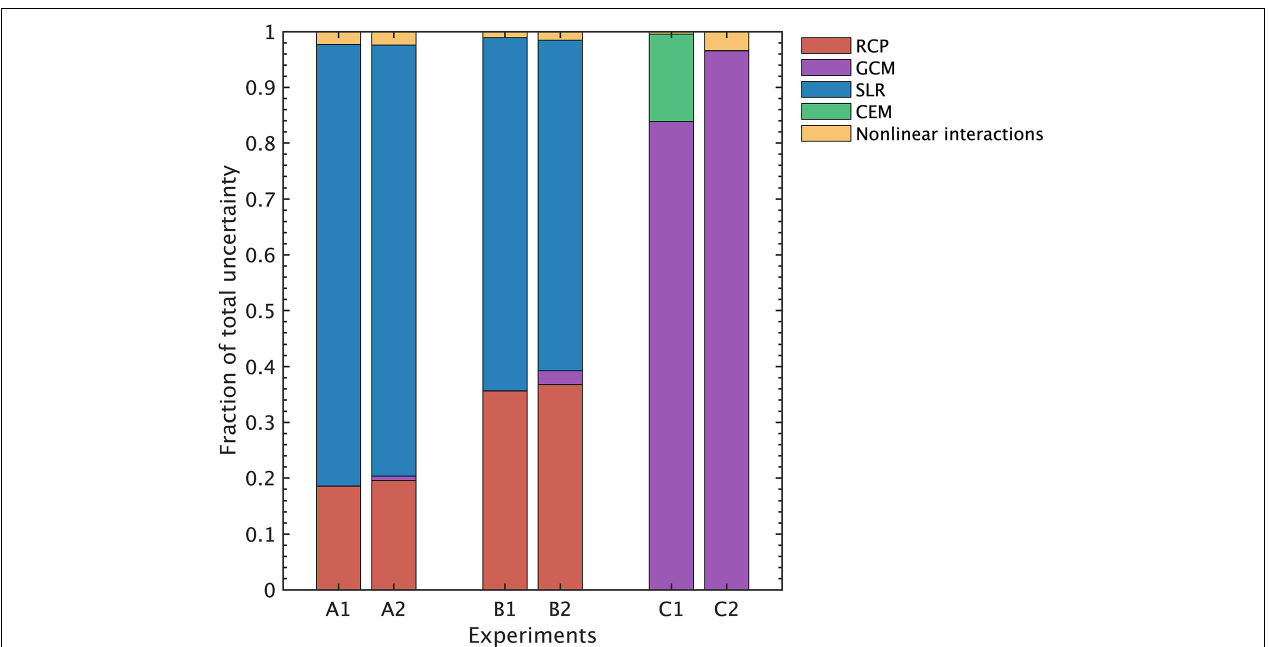
FIGURE 8 | Contribution of each uncertainty source (RCPs, GCMs, SLR percentiles, and CEMs) and their interactions to total R2100 uncertainty. The variance partitioning is based on a four-factor ANOVA-based decomposition method. Experiment A compares SP1 72,000 simulations, with SP3 72 simulations (A1 and A2, respectively); experiment B compares SP1 48,000 simulations and SP3 48 simulations, both excluding the SLR 95th percentile (B1 and B2, respectively); and experiment C compares SP1 12,000 simulations and SP3 12 simulations, both constrained to RCP8.5 and SLR 95th percentile (C1 and C2, respectively).